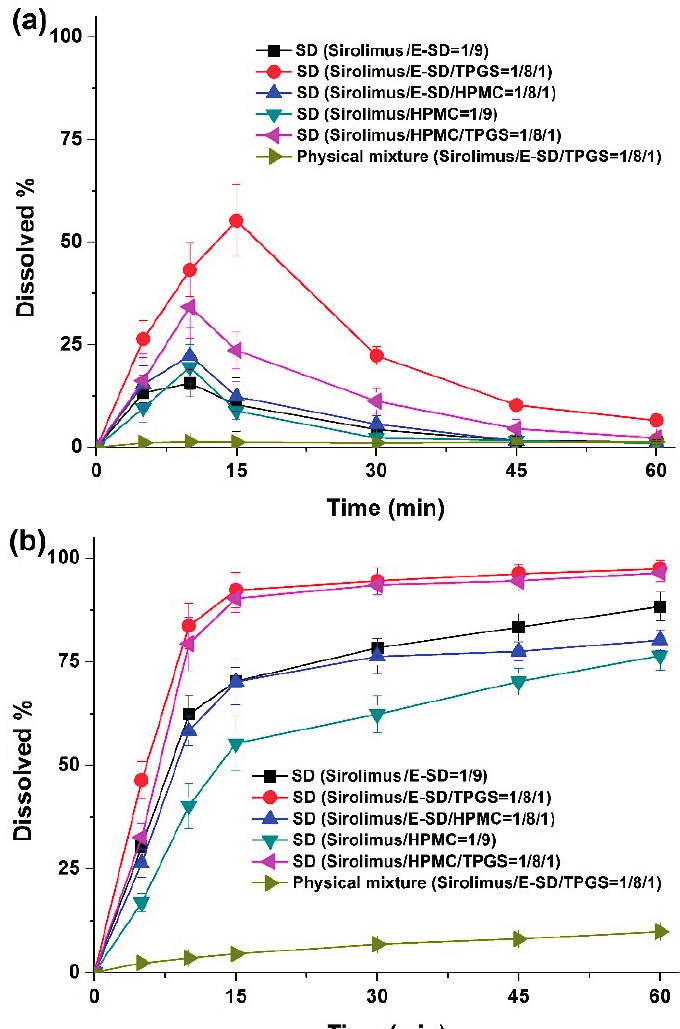
Figure 6. Dissolution profiles of sirolimus-loaded solid dispersions in media with different pHs. Simulated gastric fluid (pH 1.2) containing 0.05% w/v SLS ( a ); intestinal fluid (pH 6.8) containing 0.05% w/v SLS ( b ). Data are expressed as the mean ± standard deviation ( n =